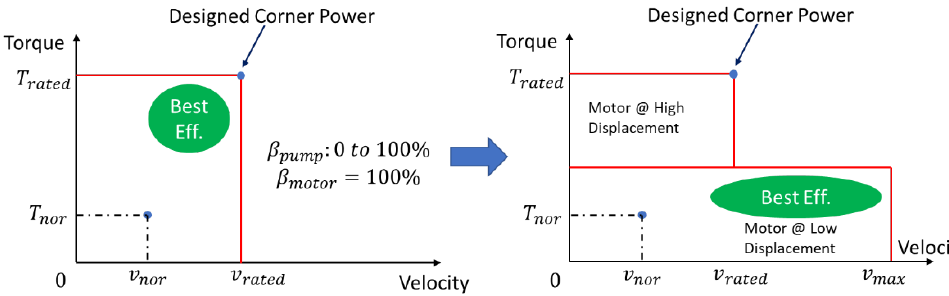
Figure 7. HT Operating Range: Reference ( Left ) vs. Solution C ( Right ).